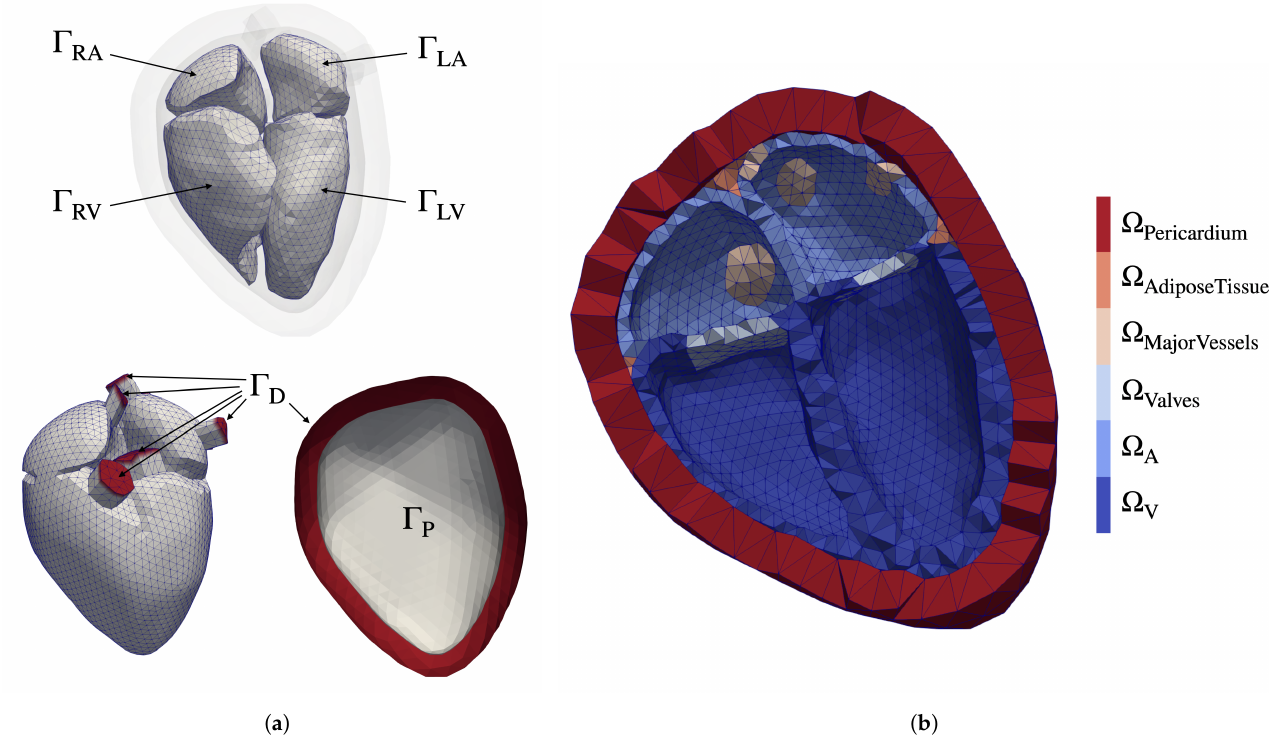
Figure 1. ( a ) triangulated surfaces used for the boundary conditions: Γ N = Γ LV ∪ Γ RV ∪ Γ LA ∪ Γ RA for the pressure in the left and right ventricle and atrium; Γ D for the dirichlet boundary; Γ P for the pericardium. ( b ) clipped reference domain Ω M of the patient specific